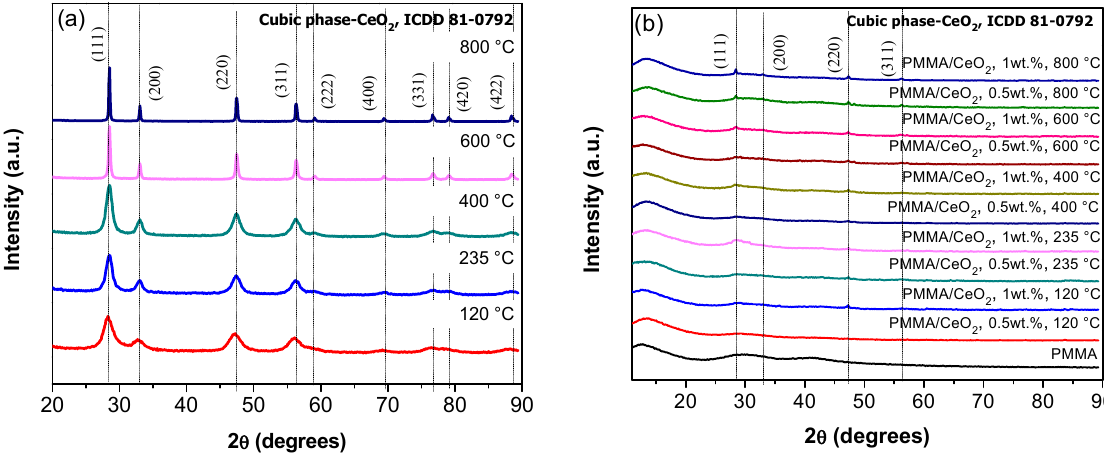
Figure 4. XRD patterns of ( a ) nanocrystalline CeO 2 powders thermally treated at different temperatures and ( b ) pure PMMA and PMMA/CeO 2 hybrid systems.